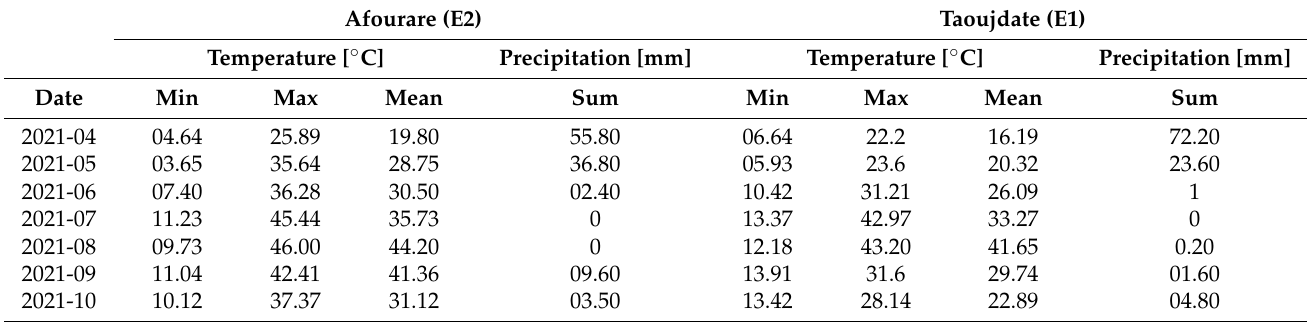
Table 2. Climatological data of the two environments during the study